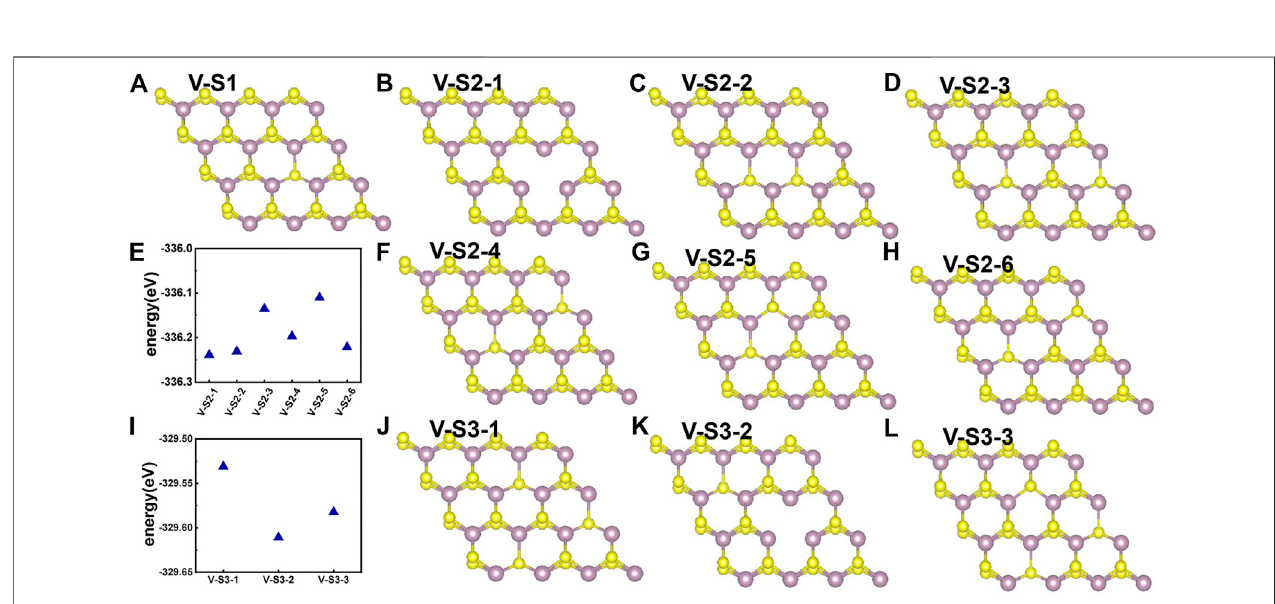
FIGURE 4 | Different S-vacancy defectstructuresof2H-MoS 2 , rotated byanangle todistinguish the two S layers: (A) singleS-vacancy; (B – D) and (F – H) six types of con fi gurationfordoubleS-vacancies; (J – L) threetypesofcon fi gurationfortripleS-vacancies; (E) and (I) comparestheground-stateenergyofdoubleandtripleS-vacancies.